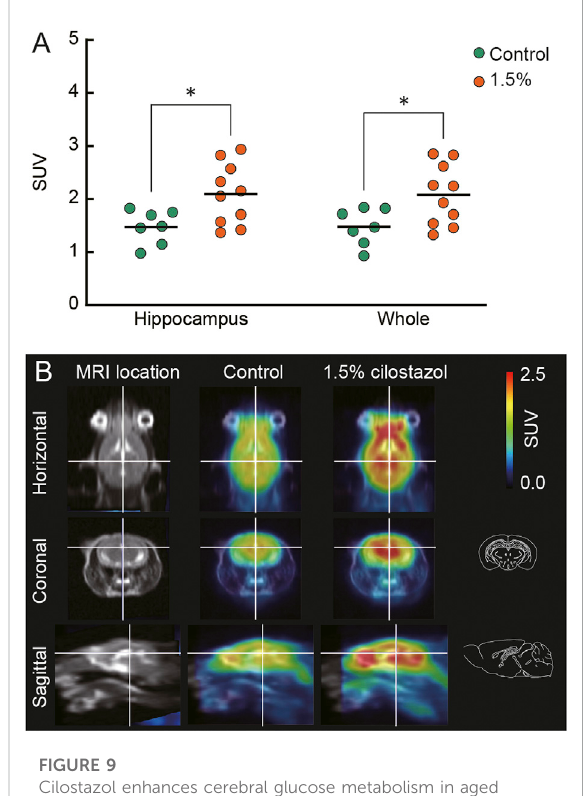
FIGURE 9 Cilostazol enhances cerebral glucose metabolism in aged mice. Cilostazol was administered to seven control (0%) and nine (1.5% cilostazol) 22-month-old mice for 1 month, and then the uptake of [ 18 F]FDG was assessed using PET. (A) Scatter dot plotrepresentingtheuptakeof[ 18 F]FDG(SUV)inhippocampusand whole brain (Whole). Student ’ s t-test revealed that mice administered 1.5% cilostazol showed signi fi cantly greater [ 18 F]FDG uptake in the hippocampus ( p < 0.05) and whole brain ( p < 0.05). * p < 0.05. Horizontal bars indicate mean values. (B) Representative T1-weightedmagneticresonanceimages(MRI)andsuperimposed PET-MRI image of mouse brains acquired after intravenous injection of [ 18 F]FDG (summed frames from 40 min to 52 min). Schematic illustrations of coronal and sagittal sections (Paxinos and Franklin, 2001) corresponding to superimposed PET-MRI images are also shown. For (A,B) 0%, or 1.5% represent the concentrationoforallyadministeredcilostazol.Blue-to-redcolors represent arbitrary unit for lower-to-higher amounts of [ 18